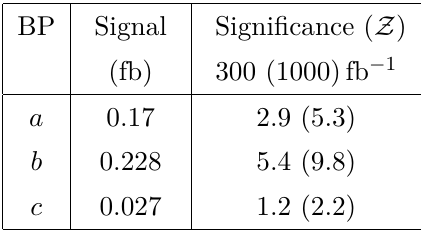
Table 3 . The background cross sections (in fb) for the bZh process after selection cuts at 14 TeV LHC. Here we added together subdominant backgrounds 4 t , t ¯ tW , tWh , tWZ and WZ +jets as “Others”. The total background (Total Bkg.) yield is provided in last column.